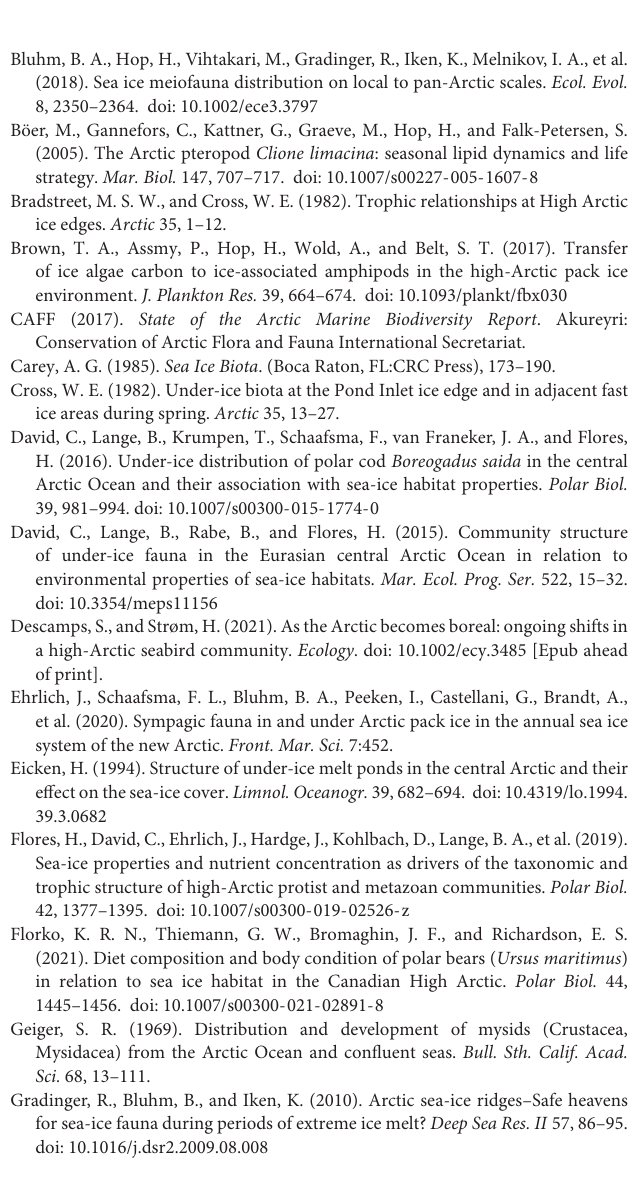
Supplementary Figure 1 | Distance from land for abundance data as indicated by the general additive mixed models (GAMM). (A) Changes in total abundance of sympagic crustaceans (excluding benthic amphipods). Blue line indicates the GAMM model, blue shading the 95% confidence intervals and dots the actual data. Note the logarithm scale on y -axis. (B) GAMM models for the abundance of four amphipod taxa. The values are presented as the centered covariate scale of the annual smoother. Dots indicate